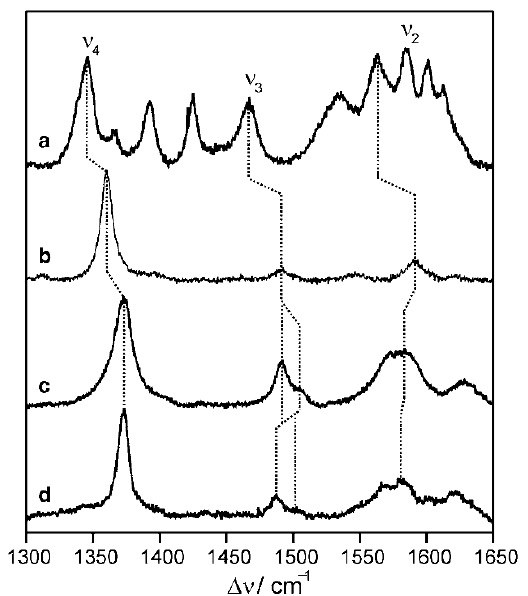
Figure 8. Comparison of the surface-enhanced resonance Raman (SERR) (b and c) and RR (a and d) spectra of cytochrome P450 adsorbed on a self-assembled monolayer (SAM) coated Ag electrode and in solution, respectively. (a) RR of dithionite reduced form; (b) SERR of reduced form at −0.40 V poised potential; (c) SERR of oxidized form at 0.34 V poised potential; (d) RR of oxidized form. Reprinted from Todorovic et al. [70], Copyright (2005), with permission from Springer.